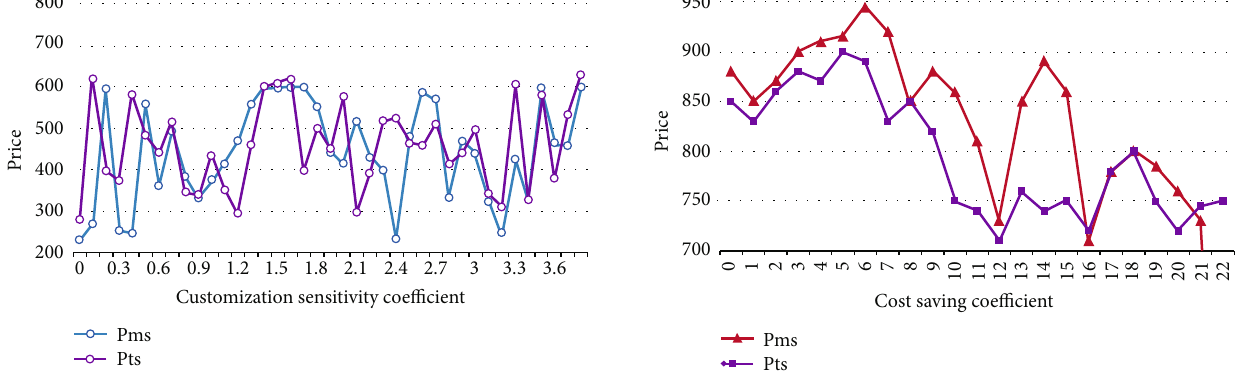
Figure 8: E ff ect of cost-saving coe ffi cient on price under the SC of 3D image processing technology.